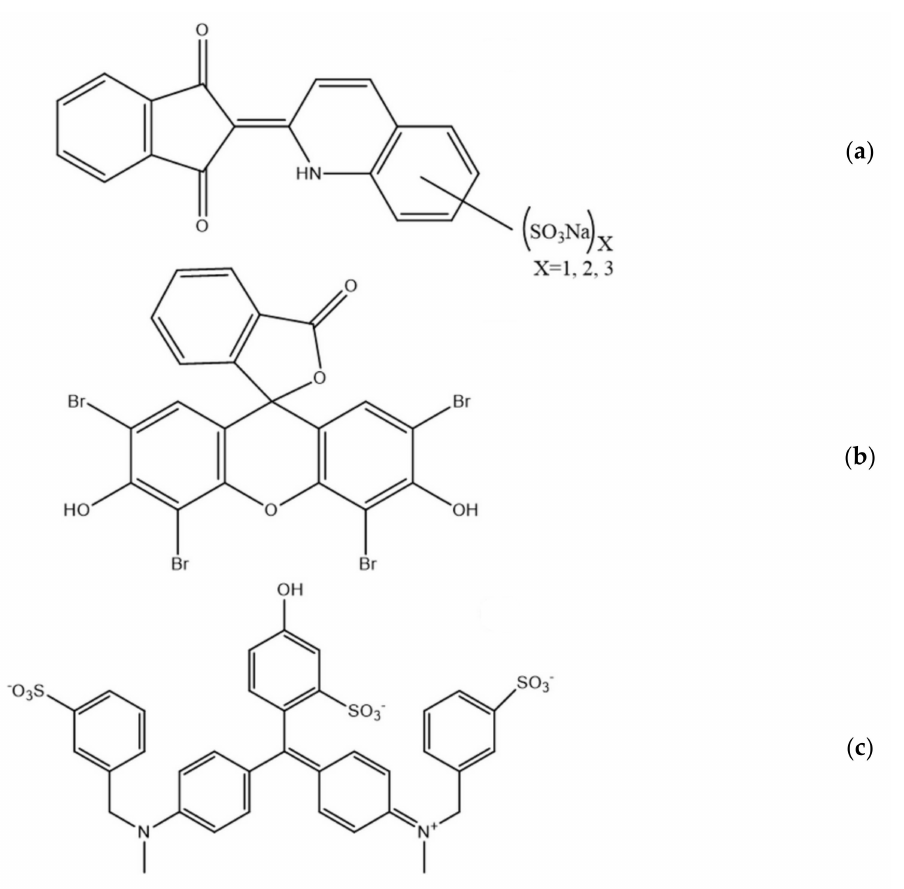
Figure 11. Chemical structures of FG ( a ), EY ( b ), and QY ( c ) dyes. Reprinted with permis- sion from